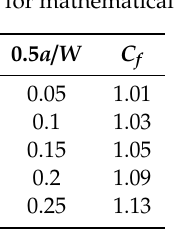
Table 4. Finite-width correction factors for mathematical model given in Equations (3) and